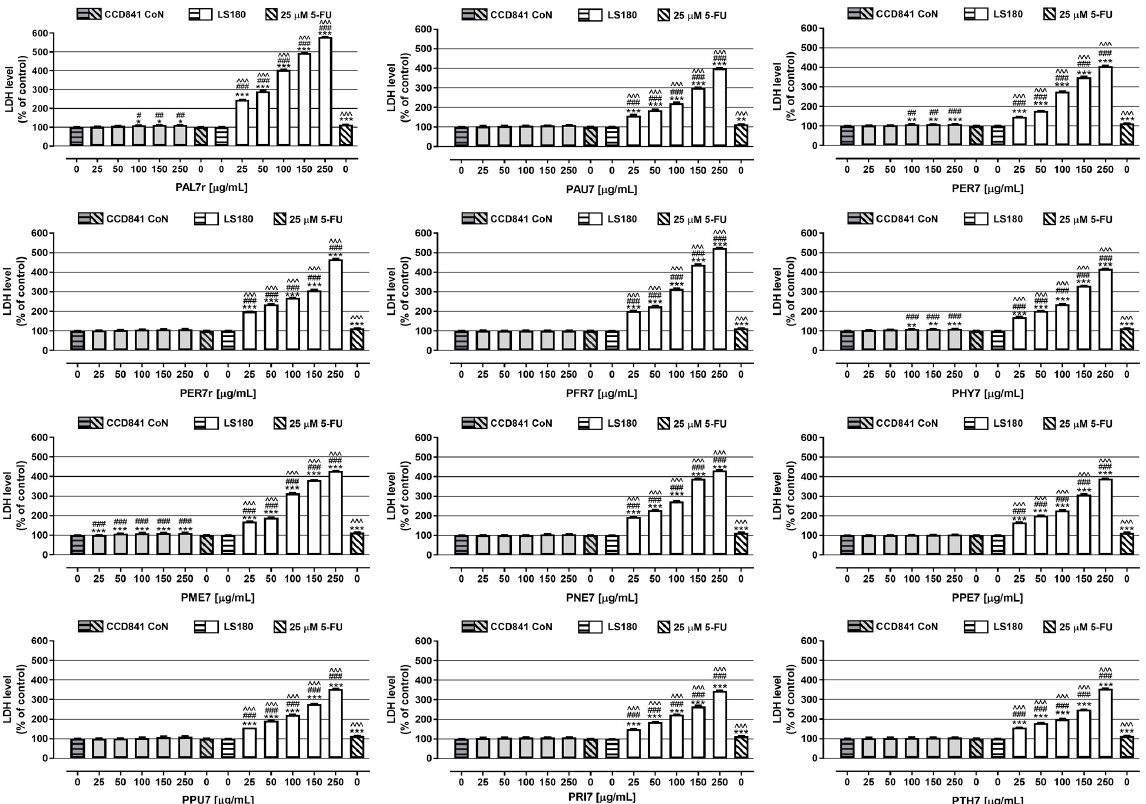
Figure 3. The influence of extracts on cell membrane integrity of CCD841 CoN and LS180 cell lines. The cells were exposed for 48 h to the culture medium alone (control). extract at concentrations of 25–250 µg/mL. or 25 µM 5-fluorouracil (5-FU; positive control). Extracts’ cytotoxicity (level of LDH released into the cell culture medium from damaged cell membranes) was measured using an LDH assay. Results are presented as mean ± SEM of at least 3 measurements. * p < 0.05; ** p < 0.01; *** p < 0.001 vs. control. # p < 0.05; ## p < 0.01; ### p < 0.001 vs. positive control. ^^^ p < 0.001 colon cancer cells treated with extract/5-FU vs. colon epithelial cells exposed to the extract/5-FU at the corresponded concentration; one-way ANOVA test; post-test: Tukey’s.